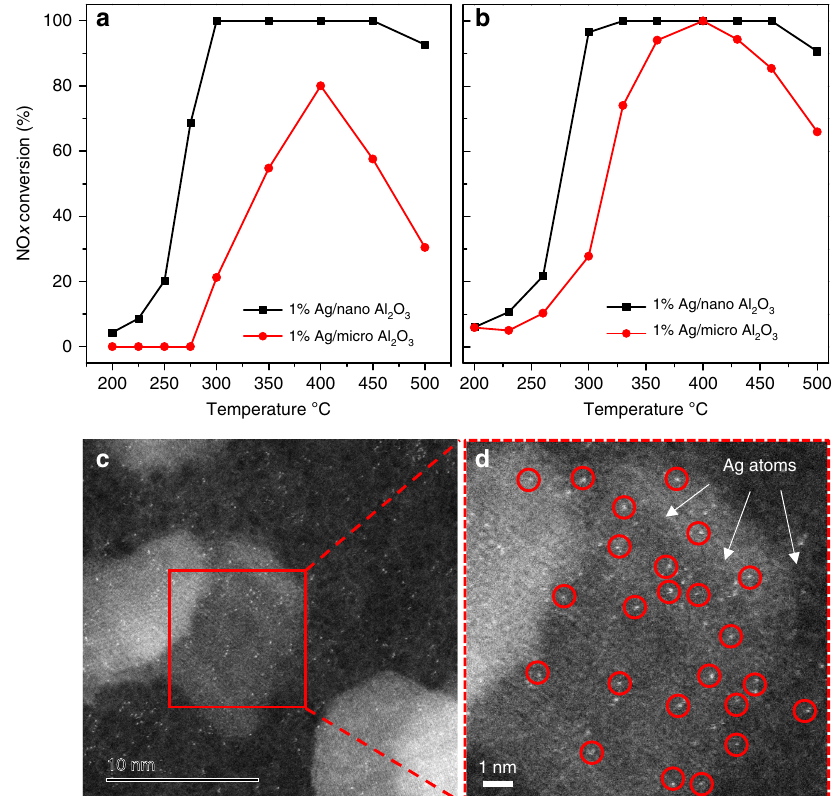
Fig. 2 HC-SCR activities of 1% Ag/ γ -Al 2 O 3 and HAADF-STEM images of 1% Ag/nano-Al 2 O 3 after testing. NO x conversion for a C 3 H 6 – H 2 -SCR (NO 800 ppm, C 3 H 6 1565 ppm, H 2 1%, O 2 10%, N 2 balance. GHSV 100,000 h − 1 ), b ethanol-SCR (NO 800 ppm, C 2 H 5 OH 1565 ppm, O 2 10%, H 2 O 5%, N 2 balance. GHSV 100,000 h − 1 ) of NO over 1% Ag/nano-Al 2 O 3 and 1% Ag/micro-Al 2 O 3 . c , d HAADF-STEM image and drawing of partial enlargement of 1% Ag/nano-Al 2 O 3 after ethanol-SCR